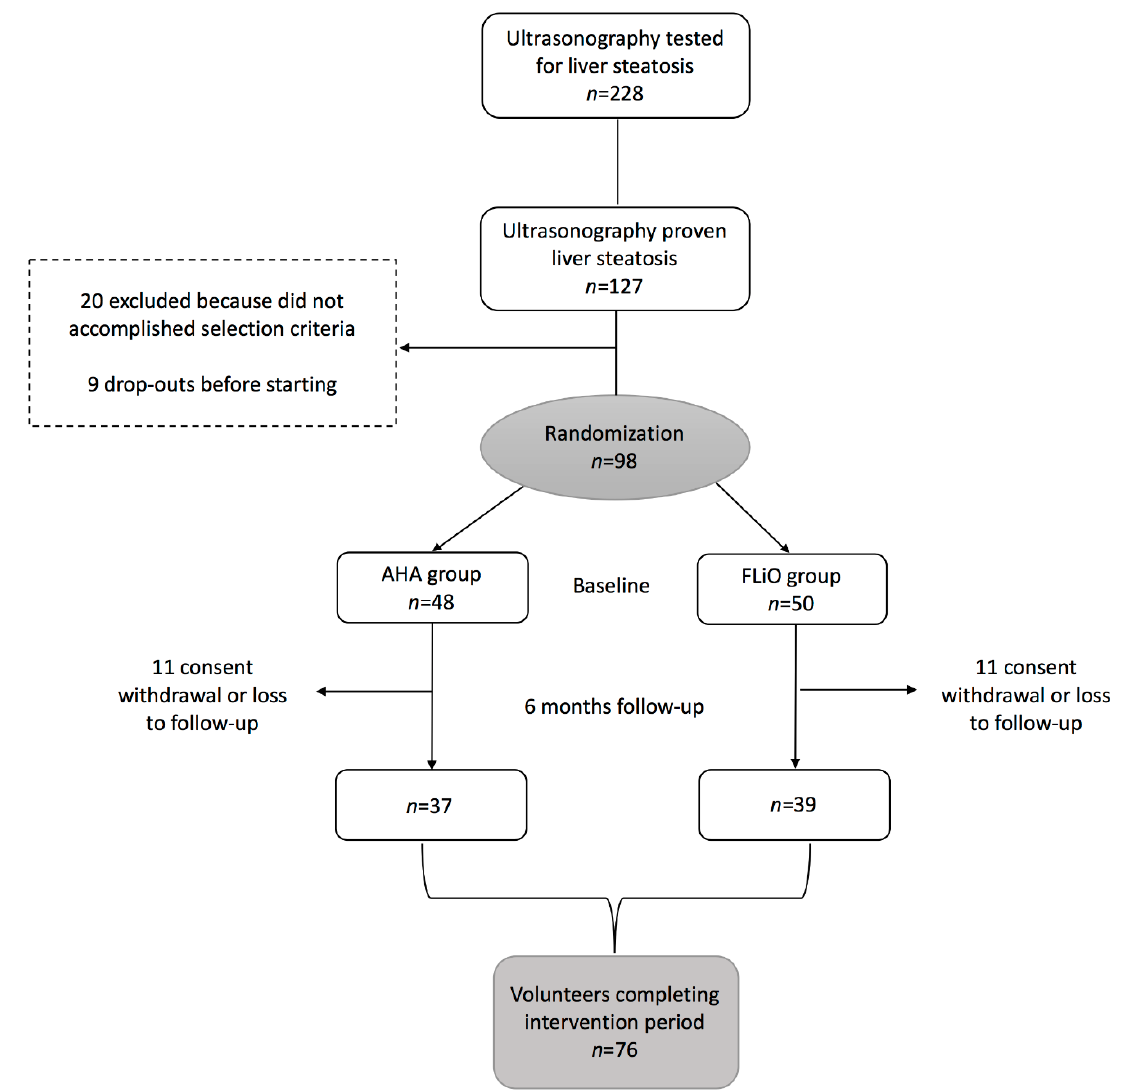
Figure 1. Flowchart of participants in the Fatty Liver in Obesity (FLiO) study.